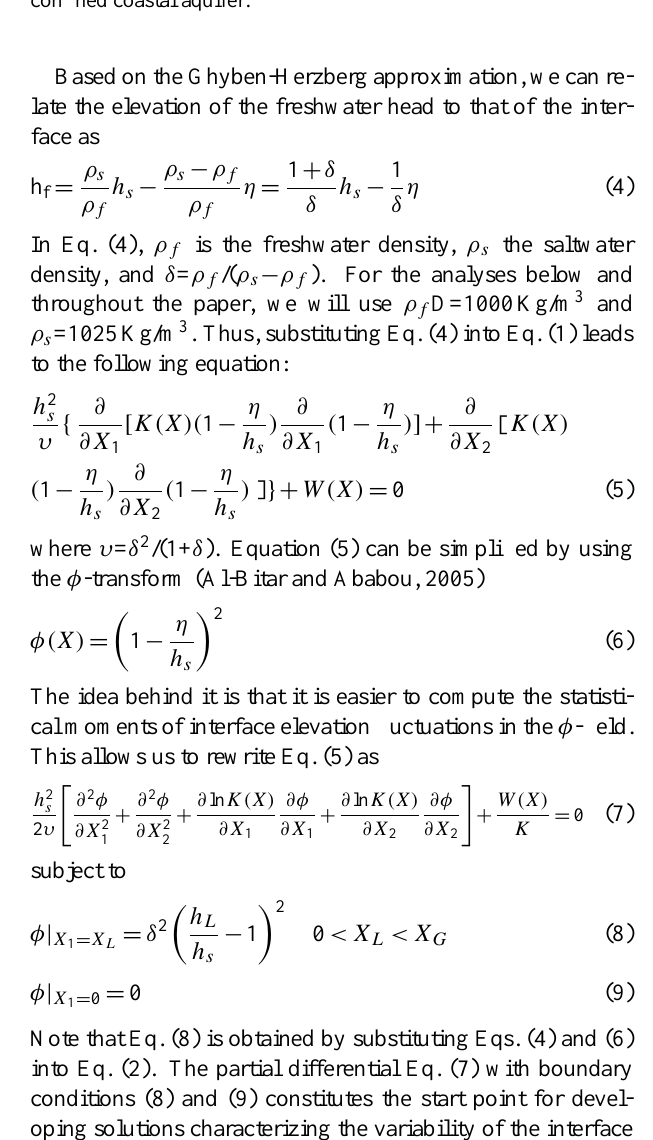
Fig. 1. Schematic representation of seawater intrusion into an un- confined coastal